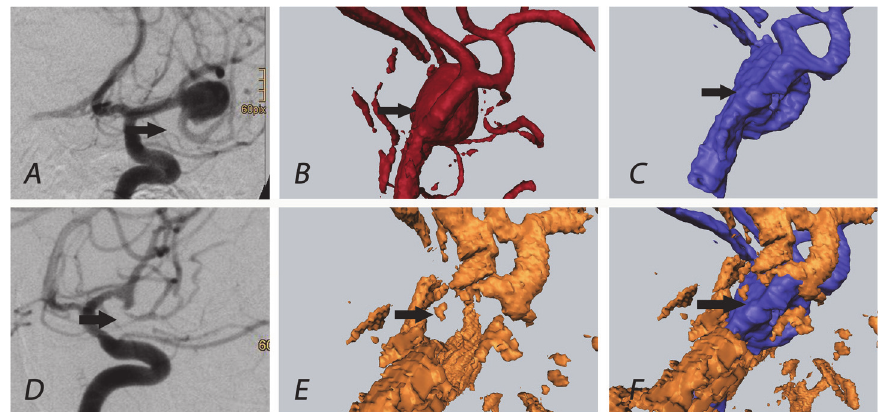
ioUS; F: coregistration of C+E.